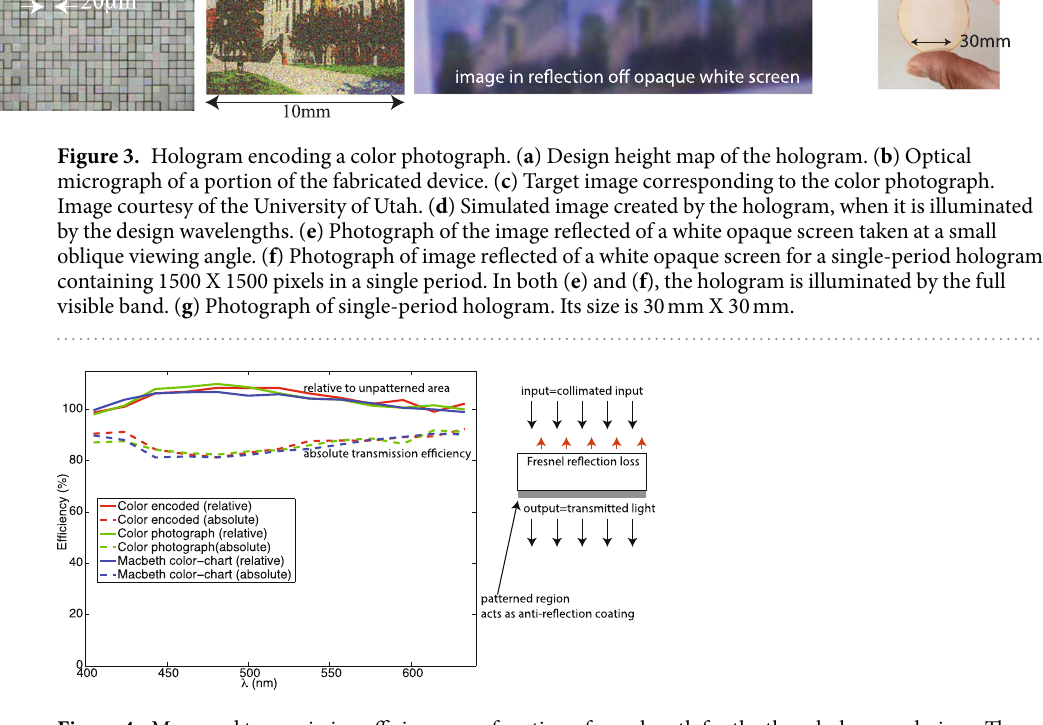
Figure 4. Measured transmission efficiency as a function of wavelength for the three hologram designs. The absolute transmission efficiencies are plotted using dashed lines, while the transmission efficiency relative to an unpatterned area is shown with solid lines. Right Inset shows how the patterned region reduces reflection losses, which allows for greater than 100% relative